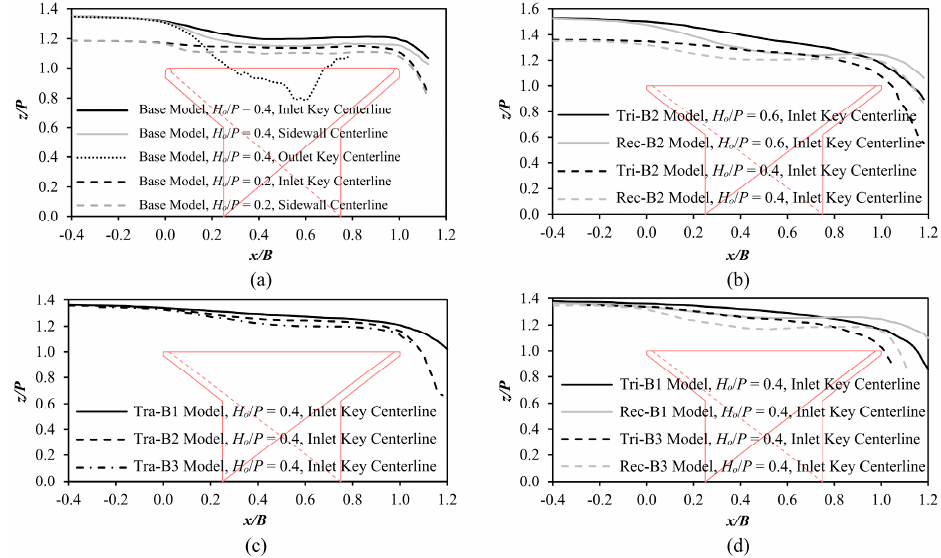
Figure 5. Water surface profiles in different models with various headwater ratios ( H o / P ): ( a ) base model; ( b ) Tri-B2 and Rec-B2 models; ( c ) Tra-B1, Tra-B2, and Tra-B3 models; ( d ) Tri-B1, Rec-B1, Tri-B3, and Rec-B3 models.